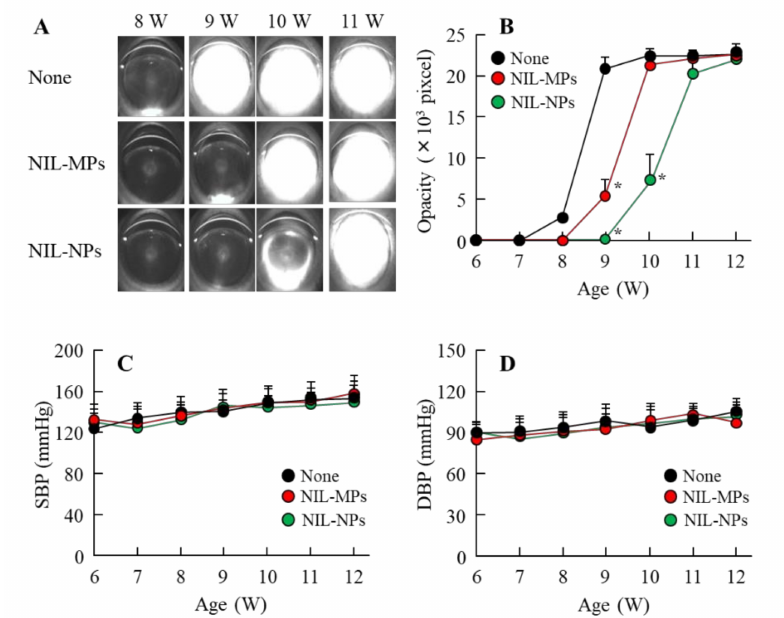
Figure 7. Changes in the opacity and BP in the SCRs repetitively instilled with NIL-NP dispersions. ( A , B ) Scheimpflug slit images ( A ) and opacity levels ( B ) in the SCRs repetitively instilled with NIL-NP dispersions. SBP ( C ) and DBP ( D ) profiles in the SCRs repetitively instilled with NIL-NP dispersions. The 6-week-old SCRs were repetitively instilled with NIL dispersions for 6 weeks (once a day). None: non-instilled SCRs. NIL-MPs: NIL-MP-instilled SCRs. NIL-NPs: NIL-NP-instilled SCRs. n = 4–11. * p < 0.05, vs. none for each group. The repetitive instillation of NIL-NP dispersions significantly delayed the onset of opacification in comparison with non-instilled and NIL-MP-instilled SCRs. On the other hand, NIL-NP dispersions did not affect the